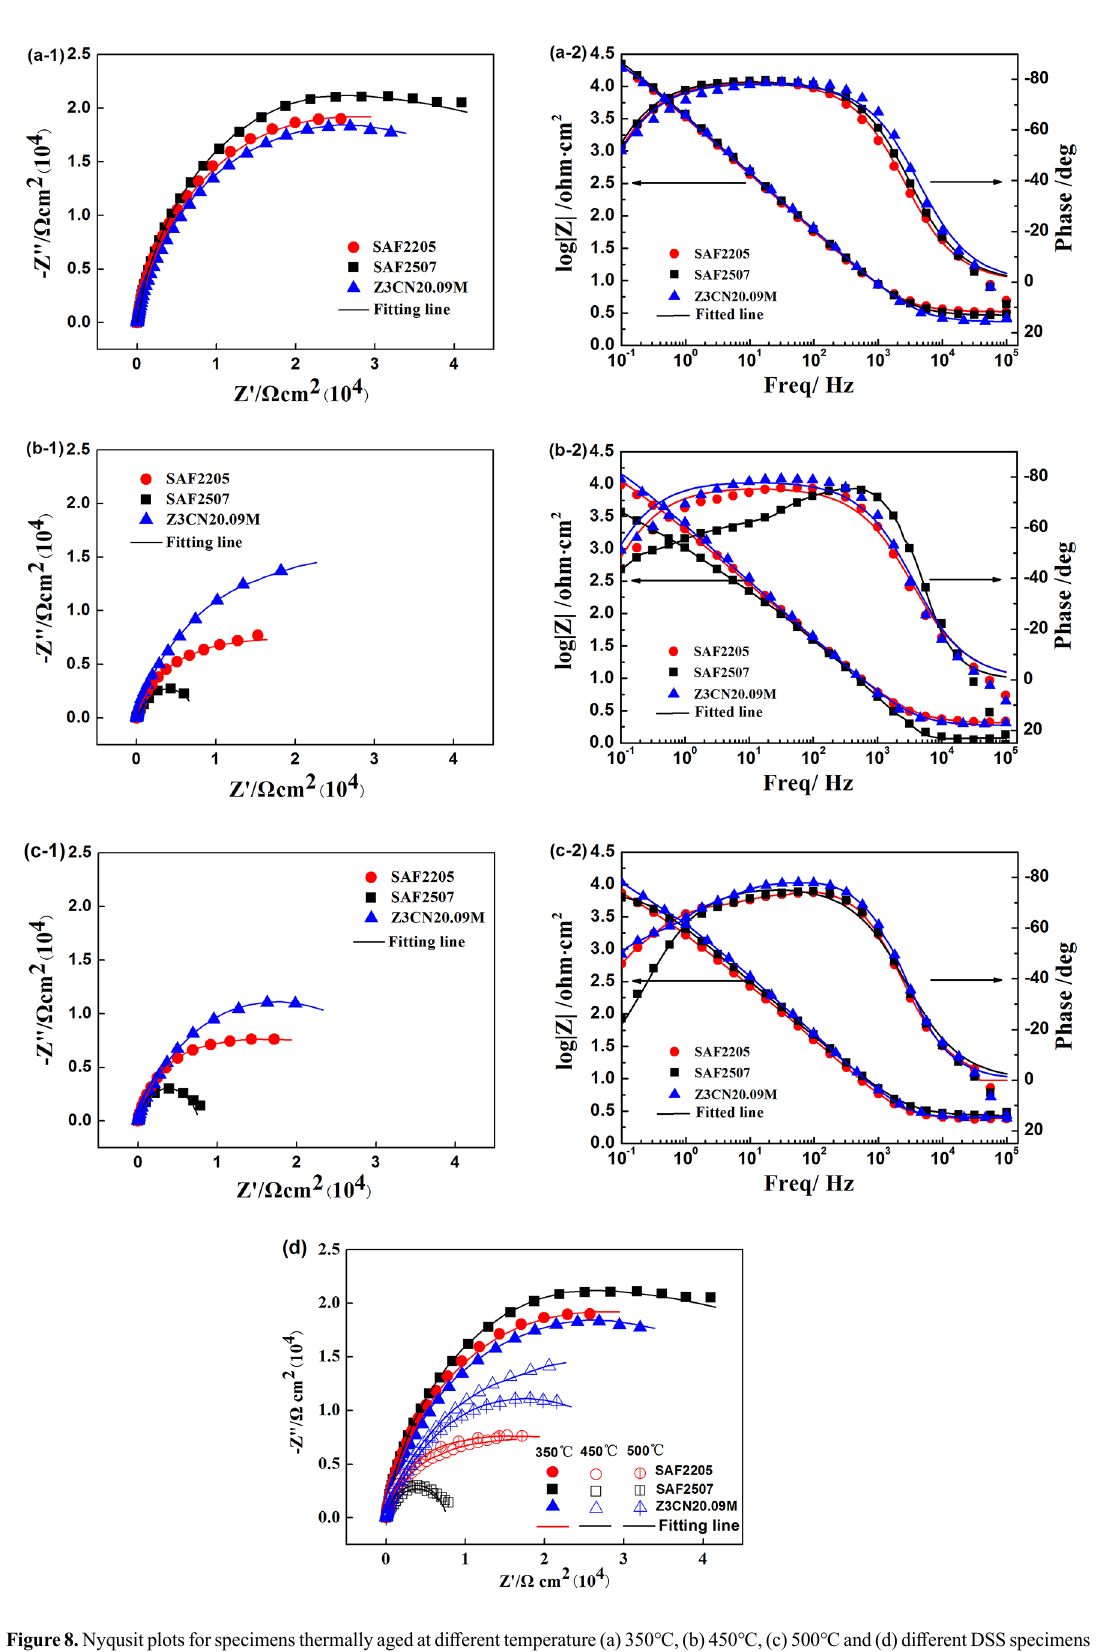
Figure 8. Nyqusit plots for specimens thermally aged at different temperature (a) 350℃, (b) 450℃, (c) 500℃ and (d) different DSS